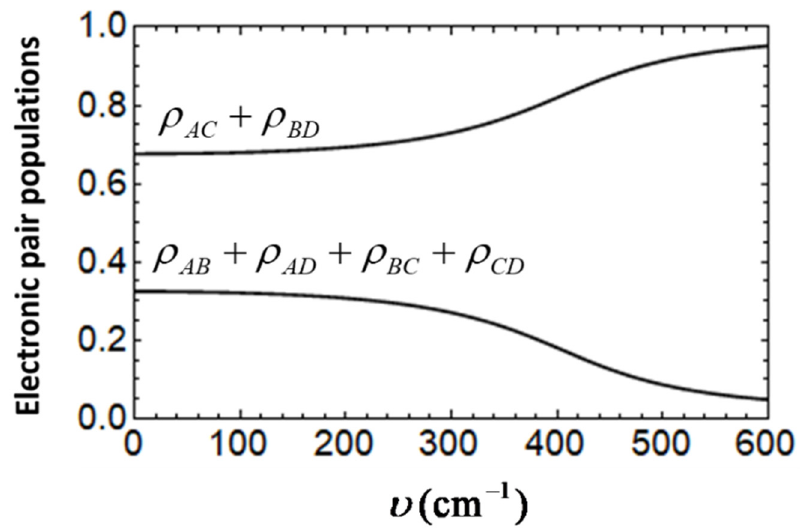
Figure 5. Overall probabilities of the diagonal-type and the side-type two-electron populations in a free cell calculated as functions of the vibronic coupling parameter υ .